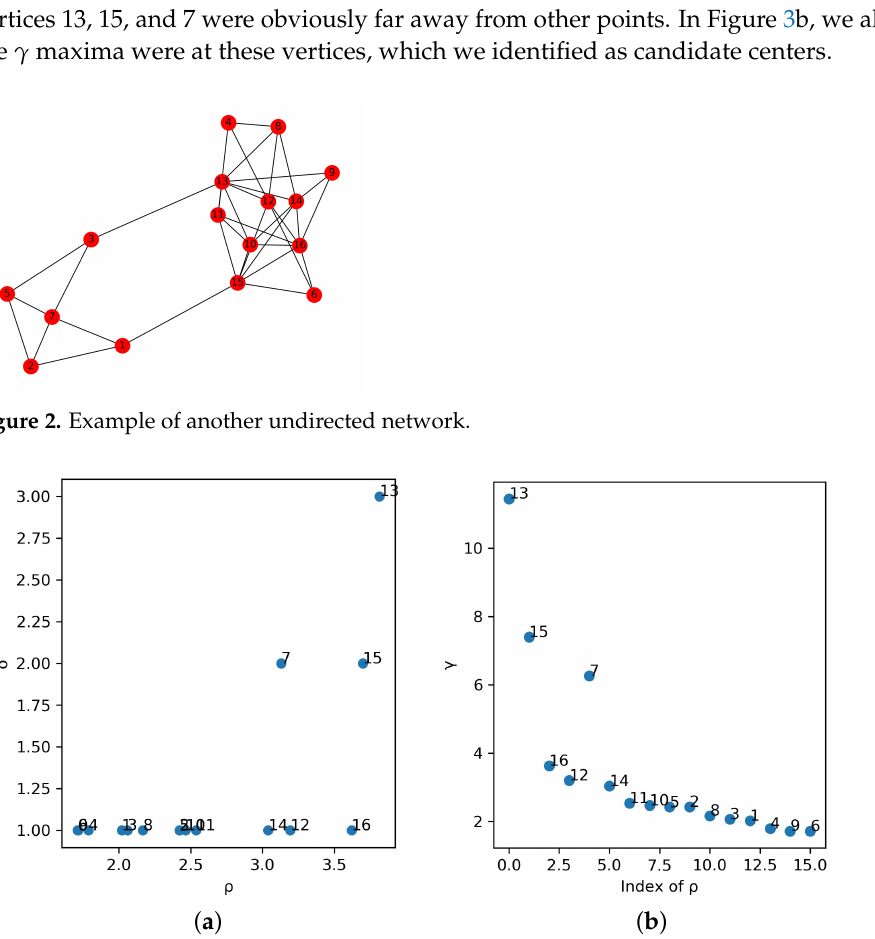
Figure 3. Decision diagrams for the example network. ( a ) Decision diagram for the vertices. ( b ) γ